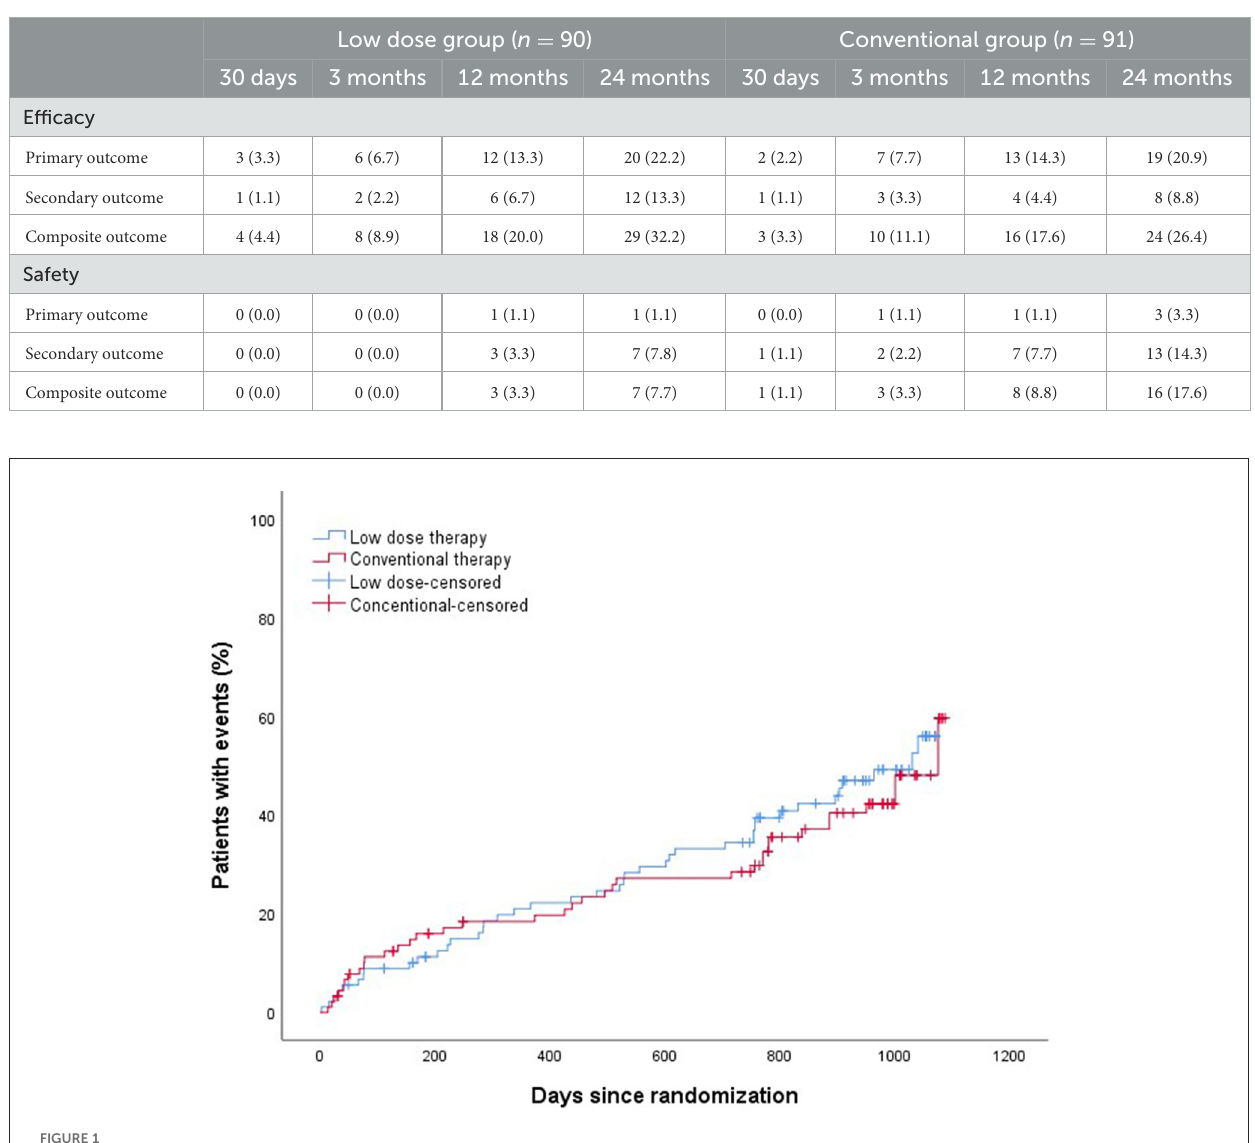
FIGURE1 Kalpan–Meier analysis of composite efficacy